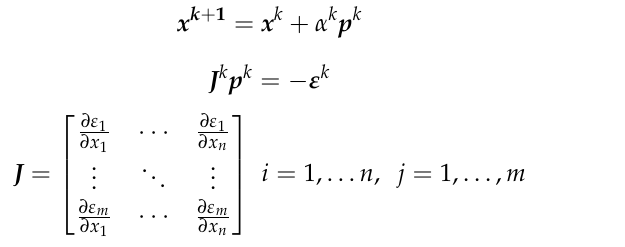
√ . m θ 020 LPC , in δ 020 √ . m θ 025 HPC , in δ 025 √ . m T 0,041 HPT , in P 0,041 √ . m T 0,046 LPT , in P 0,046 . W HPT η mech , HP √ . m θ 120 fan , in δ 120 . W LPT η mech , LP